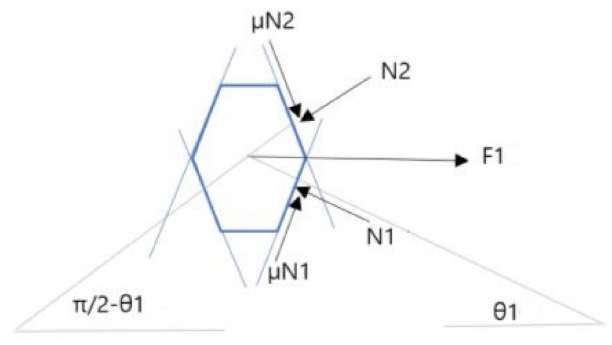
Figure 7. The force on the push piece.